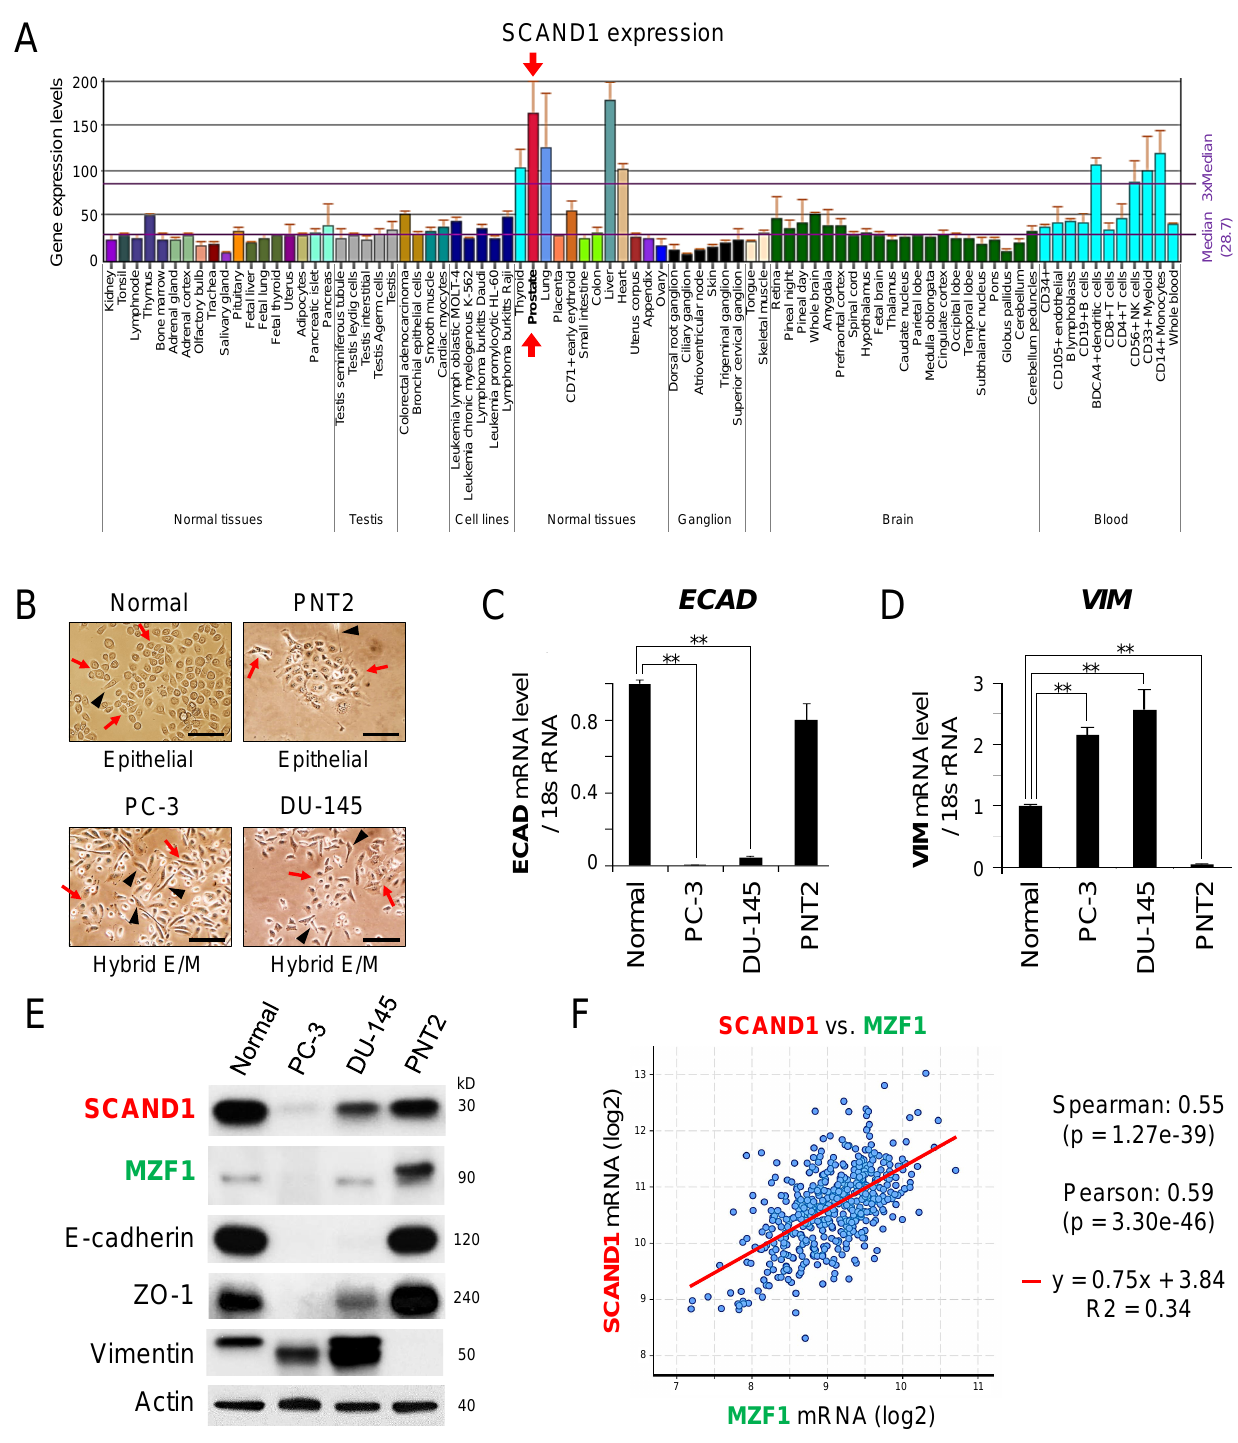
Figure 1. SCAND1 expression is involved in epithelial features of the prostate. ( A ) SCAND1 gene expression in various tissues. Data were obtained from BioGPS database. ( B ) Morphologies of normal prostate cells, PNT2, PC-3, and DU-145 cells. Red arrows indicate polygonal, cobblestone- like epithelial cells. Arrowheads indicate spindle-shaped mesenchymal cells. Scale bars, 100 µ m. ( C , D ) ECAD and VIM mRNA expression evaluated by qRT-PCR. ** p < 0.01 (versus Normal), n = 3. ( E ) Western blotting of SCAND1, MZF1, E-cadherin, ZO-1, and vimentin. Actin, loading control. Blots of SCAND1 and actin were also published in ref [28]. ( F ) Co-expression correlation analysis of SCAND1 and MZF1 mRNA in prostate adenocarcinoma